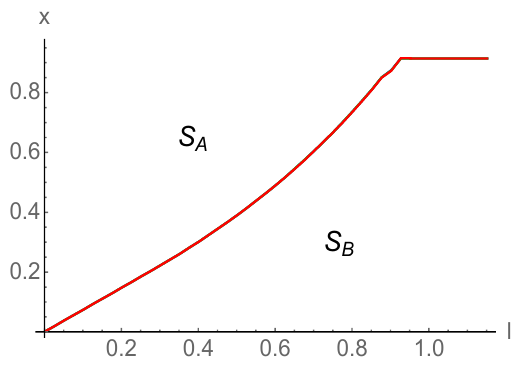
Figure 29 . Two strip phase diagram of the specious-con(cid:12)ned phase for various values of T . The S A and S B phases correspond to the two connected bulk surfaces of (cid:12)gure 6. Here (cid:22) = 0 and red, green and blue curves correspond to T=T c = 0 : 9, 0 : 8 and 0 : 7 respectively. In units GeV.